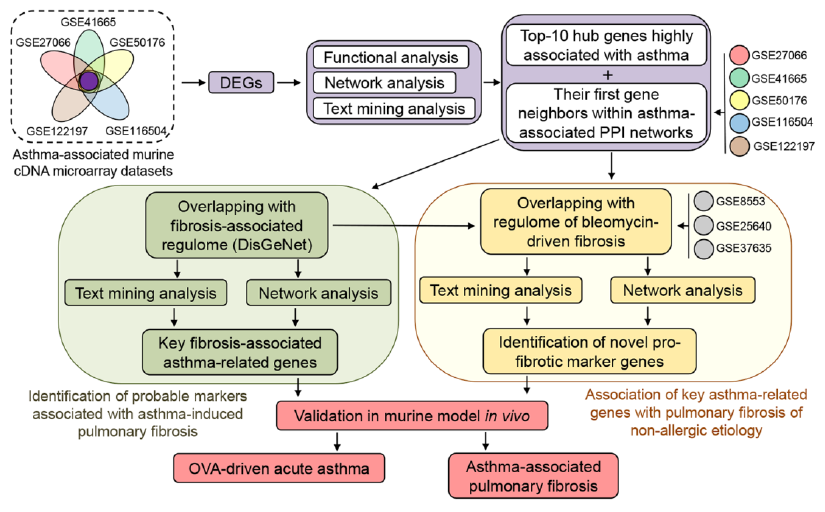
Figure 1. Workflow of the present study.